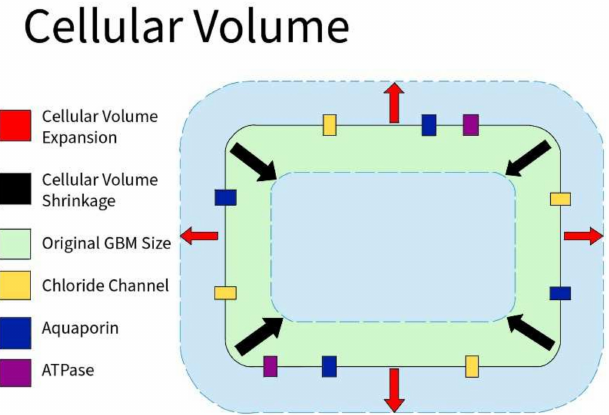
Figure 7. Cellular Volume in GBM. GBM cells express an abundance of chloride ion channels. Along with aquaporin channels and various ATPases, those channels allow the cells to shrink or swell depending on the environment to aid in the survival of GBM